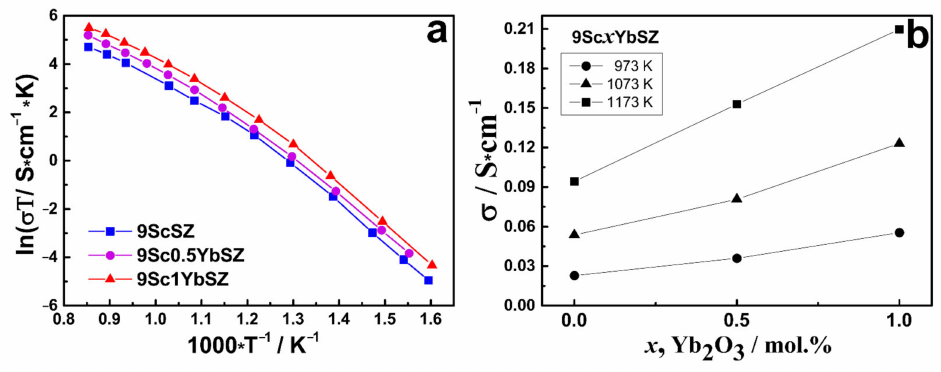
Figure 3. ( a ) Conductivity of test crystals vs temperature in Arrhenius coordinates and ( b ) Conduc- tivity of test crystals vs. Yb 2 O 3 concentration.